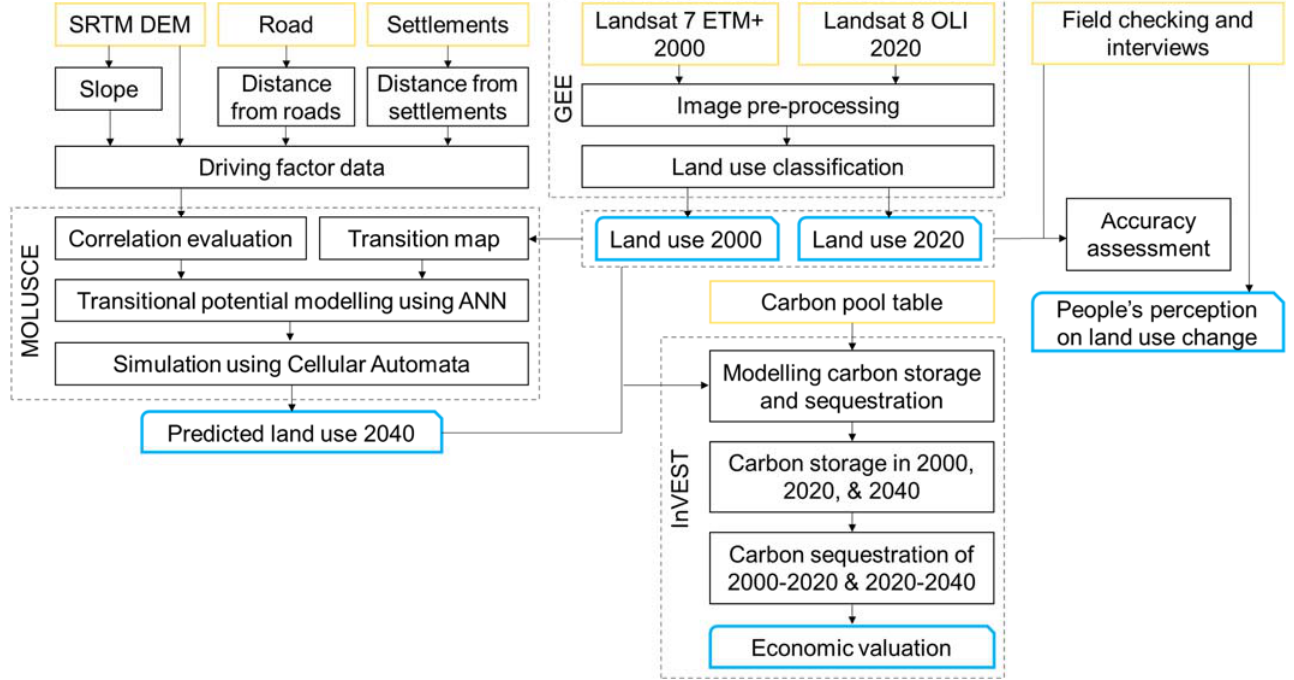
Figure 2. Flow chart of the study.